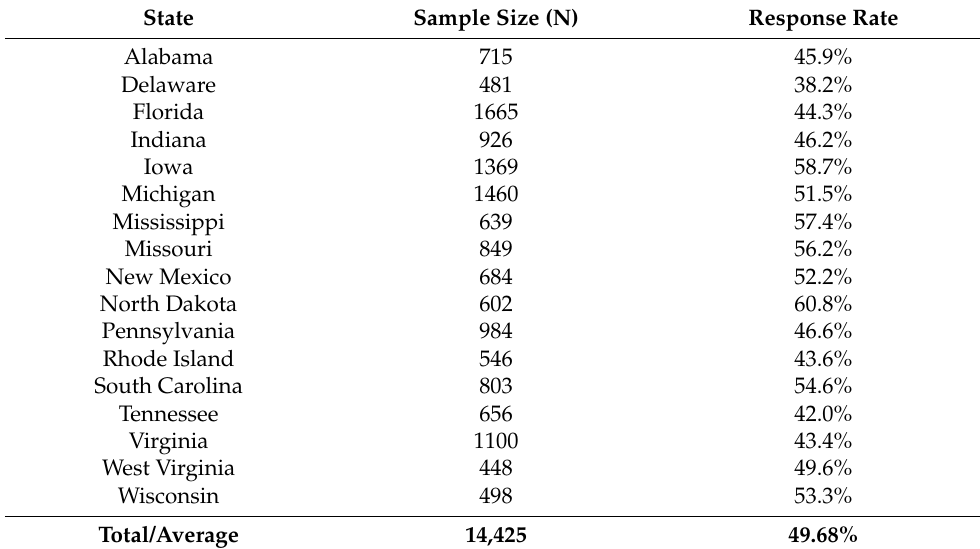
Table A1. List of states in analytic sample (BRFSS 2019 Survey, young adults aged 18–34).